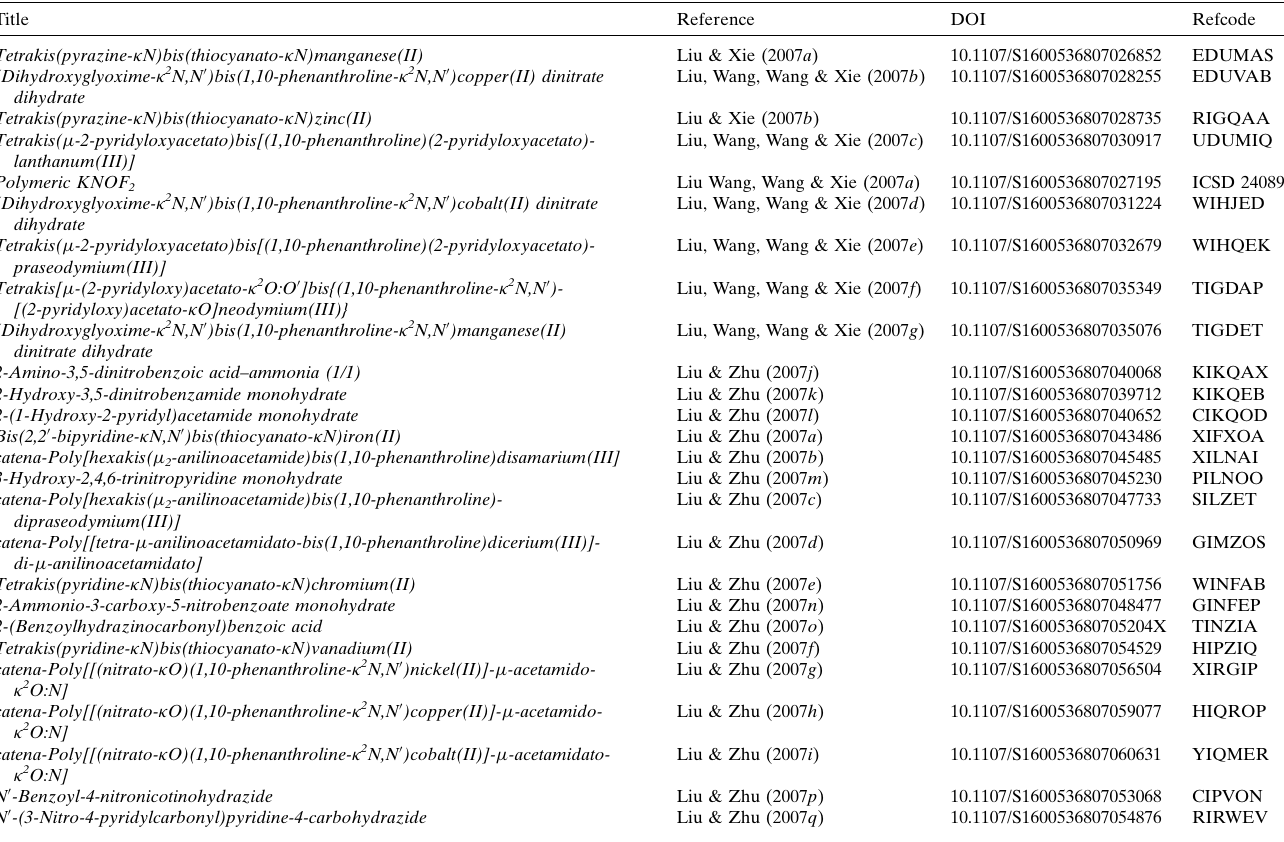
Details of articles to be retracted, in order of